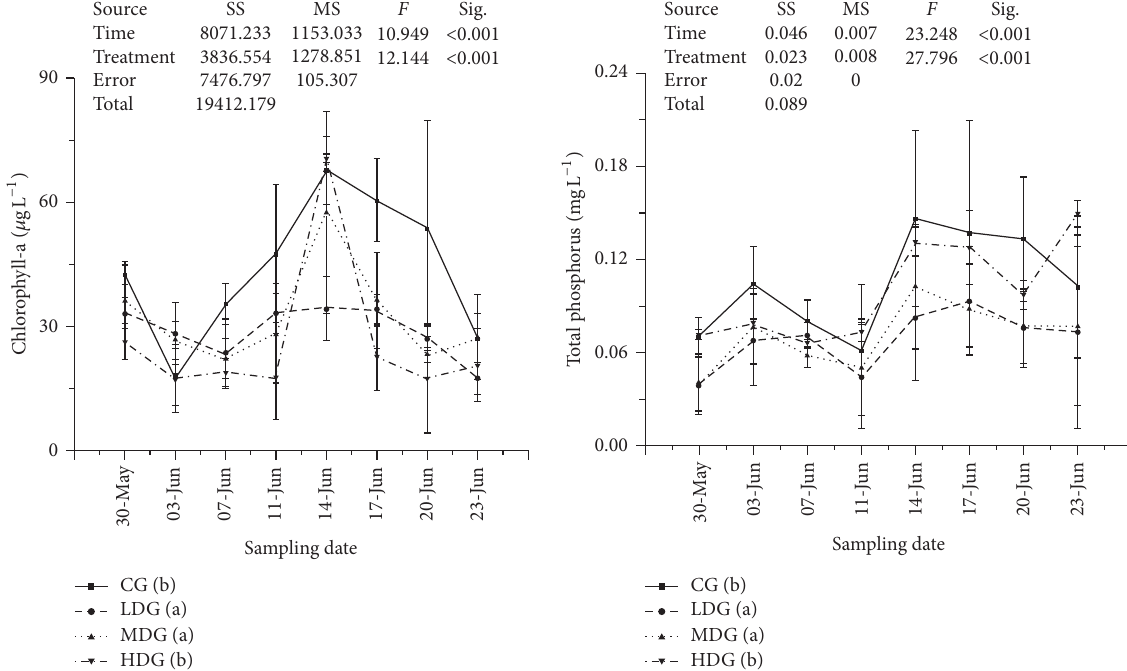
Figure 5: Nutrients values including total phosphorus and chlorophyll-a in each enclosure treatment during sampling points. Values were presented by mean ± STDEV. Treatments with different minuscules mean significant differences between each other and parameters in each treatment from low to high were arranged alphabetically (i.e., treatment with minuscule (a) means the lowest, at 𝑃 < 0.05 , 𝛼 = 0.05 ). SS: type III sum of squares, df:freedom, and MS: mean